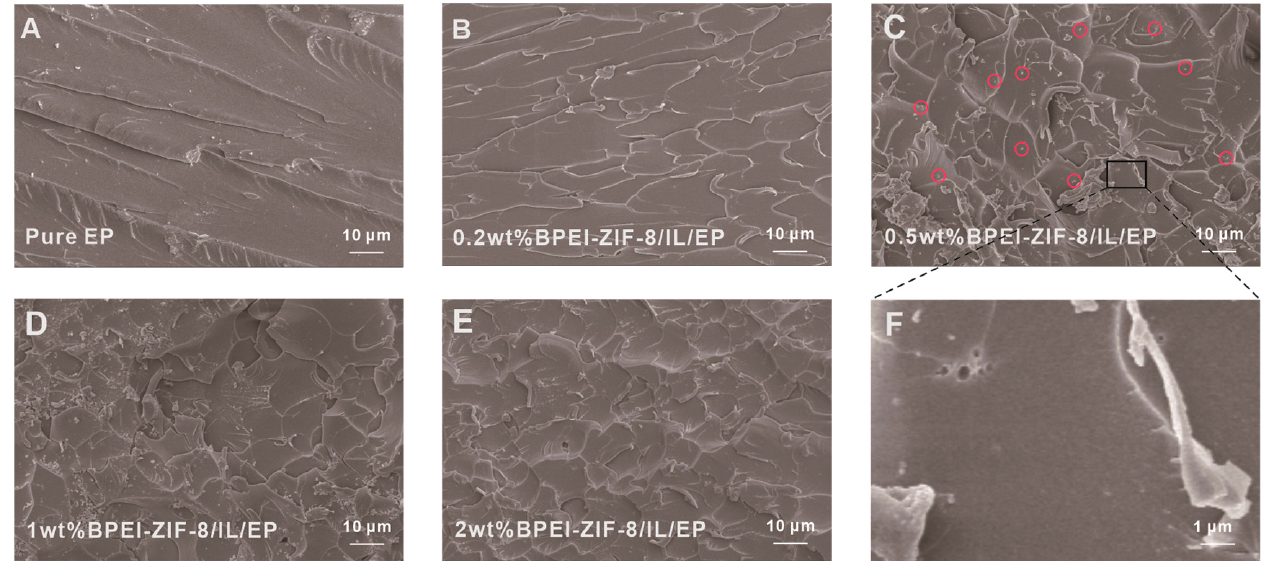
Figure 7. Chemical reactions between BPEI-ZIF-8/IL and EP ( a ) reaction of BPEI-ZIF-8 and epoxy ring, ( b ) reactions of ionic liquid and epoxy ring.